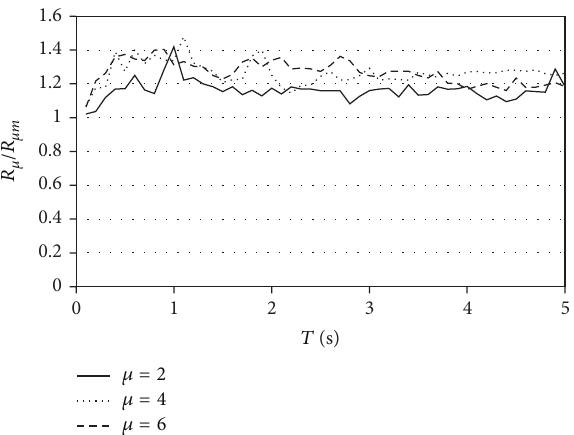
Figure 7: Average ratio between 𝑅 𝜇 and 𝑅 𝜇𝑚 for soil type